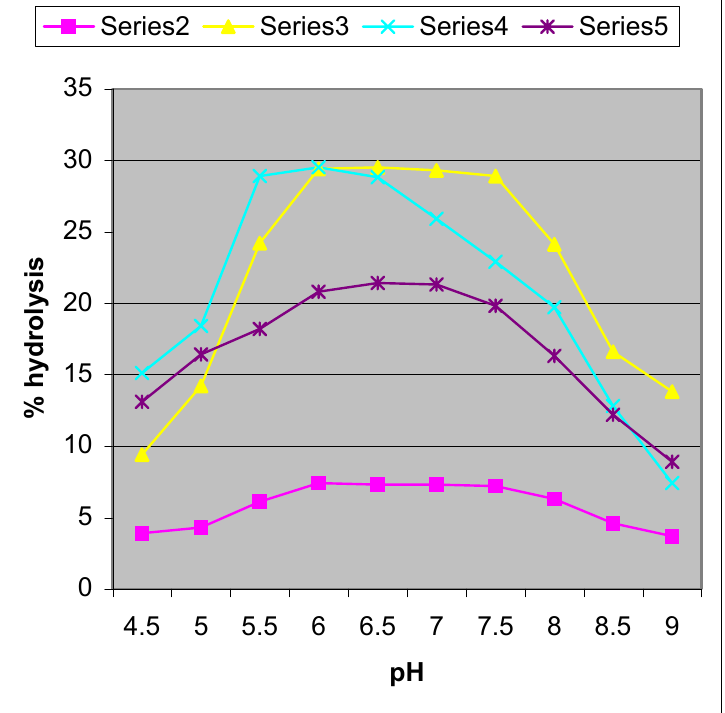
Figure2. pH-rate profile for [CoN [series5]) and Prussian blue [series4] promoted hydrolysis of NPP in microemulsion (ME2 at 25 0 C; c=5 x 10 -4 M, I = 0.1M NaClO